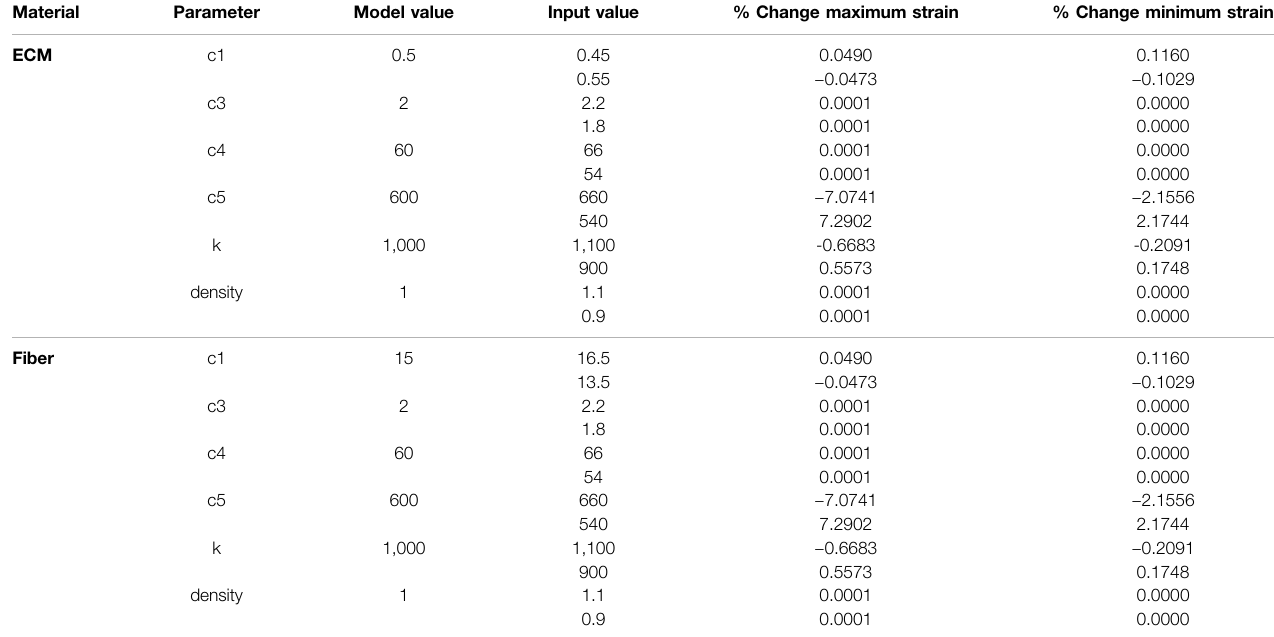
TABLE 3 | Sensitivity analysis of FE material model parameters for ECM and Fibers. Model values were varied by ± 10% (input values) and percentage changes to the maximum and minimum strain in each FE simulation are shown. Material